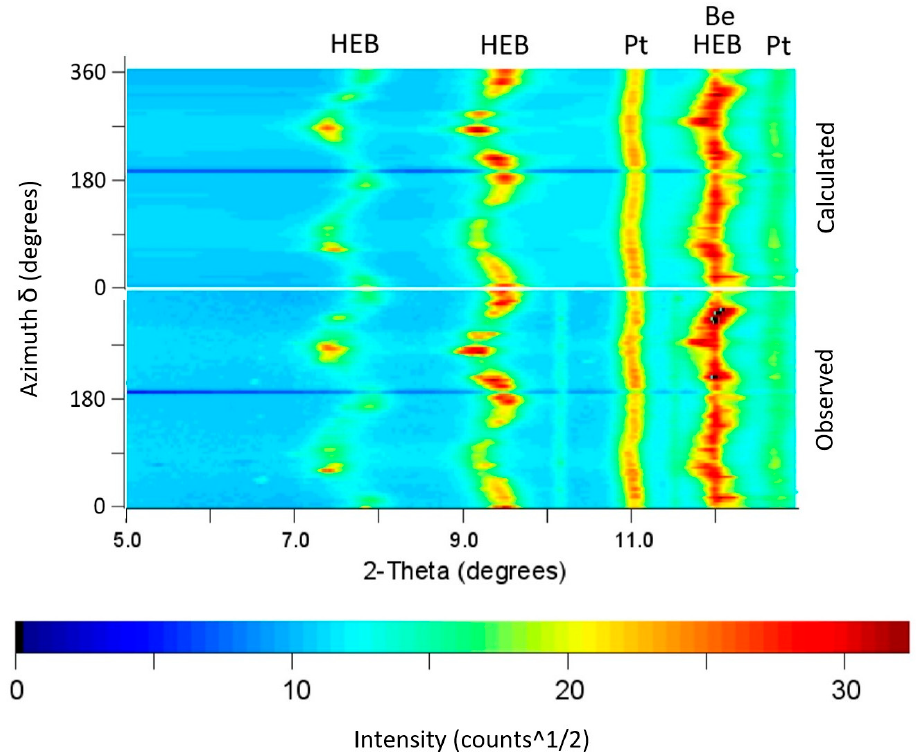
Figure 9. The X-ray diffraction pattern of the HEB sample (Hf, Mo, Nb, Ta, Ti)B 2 along with platinum (Pt) marker at a pressure of 65 GPa in a radial diffraction mode with beryllium (Be) gasket. The waviness in the diffraction lines reflects the large anisotropy in elastic strains present for a high- strength material such as HEB compared to a platinum pressure marker. The lower panel shows the observed diffraction intensities in the azimuthal direction, while the upper panel shows the calcu- lated intensities.